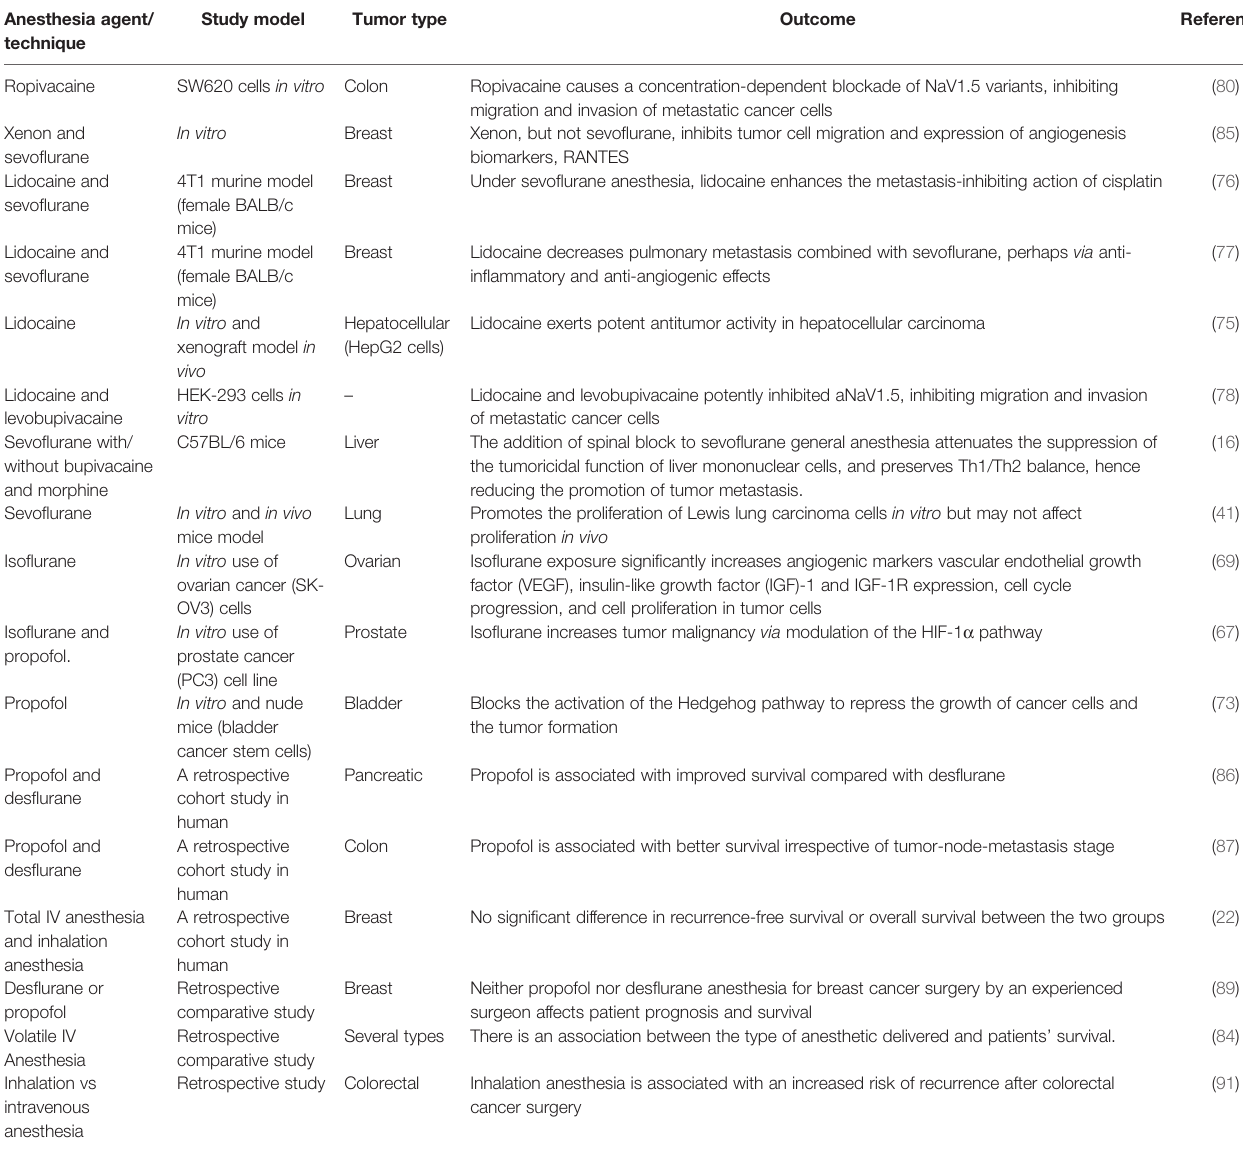
TABLE 1 | Preclinical and retrospective studies on anesthesia effects on tumor